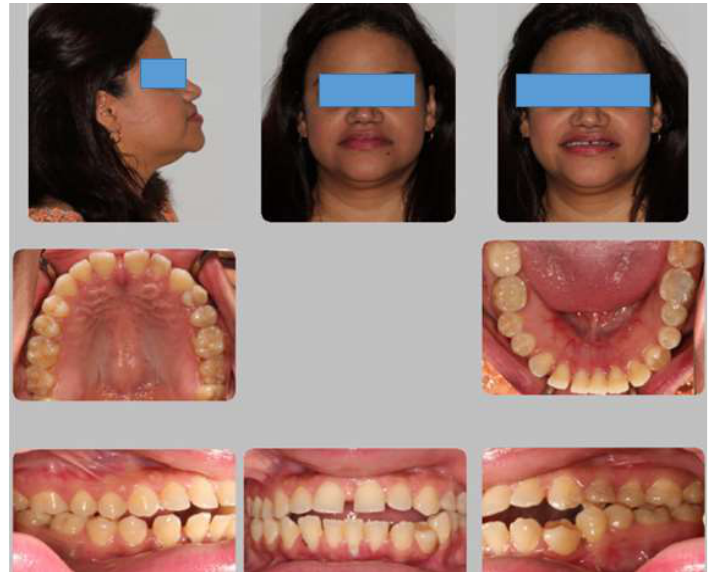
Figure 1. Initial clinical records showing anterior open bite with bi-maxillary protrusion with extra third premolar distal to lower left canine.